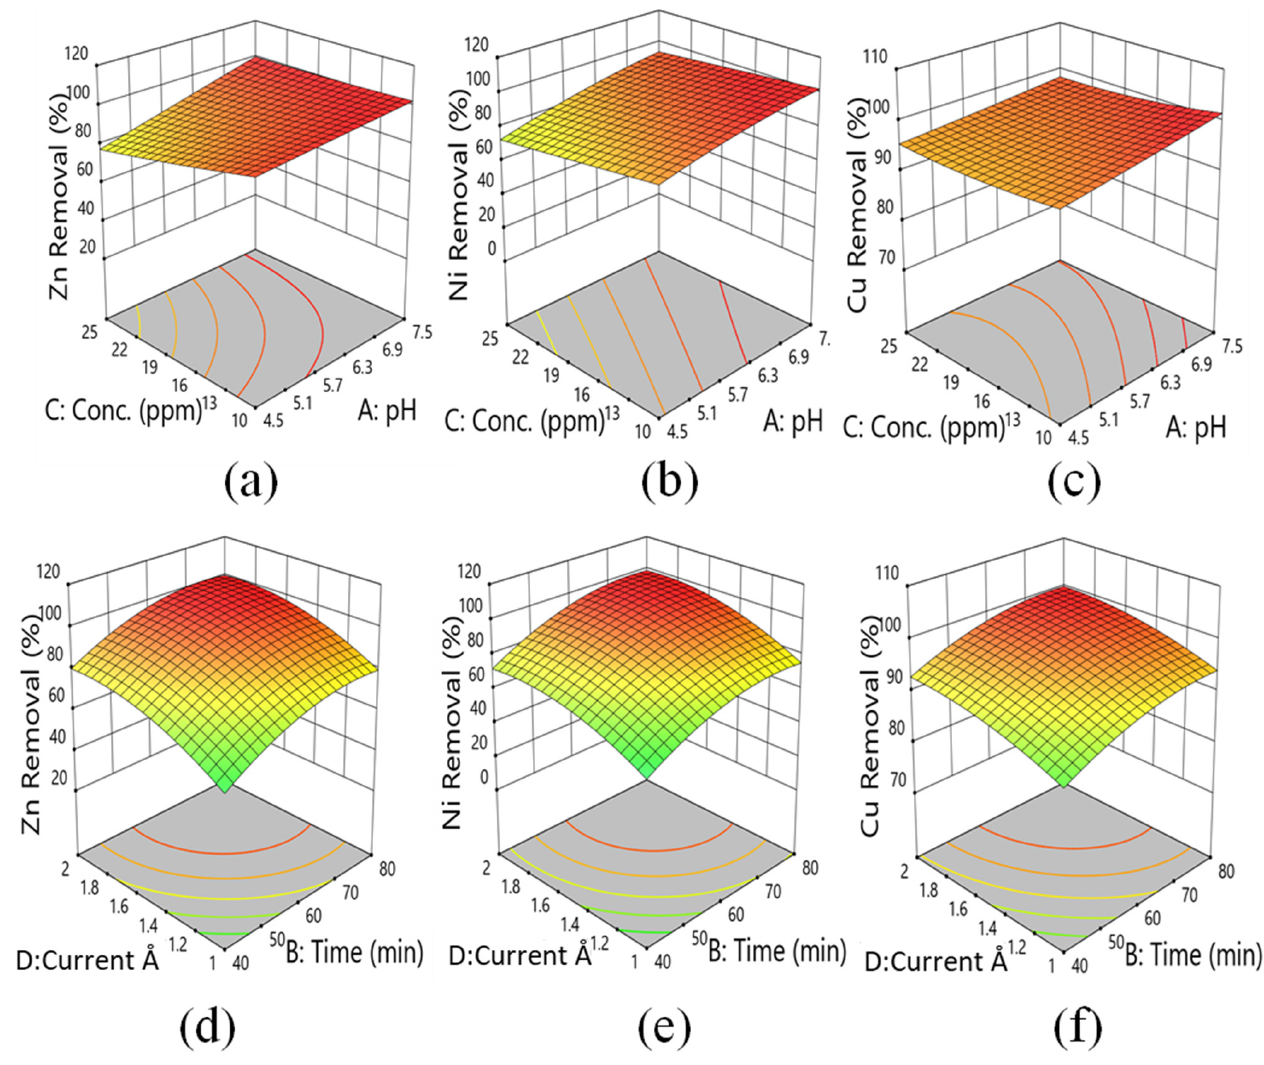
Figure 4. Electrocoagulation RSM graphs: effects of concentration and pH on removal% efficiency of metal ions: ( a ) Zn ions, ( b ) Ni ions and ( c ) Cu ions. Effect of current and reaction time on removal% efficiency of metal ions: ( d ) Zn ions, ( e ) Ni ions and ( f ) Cu ions.